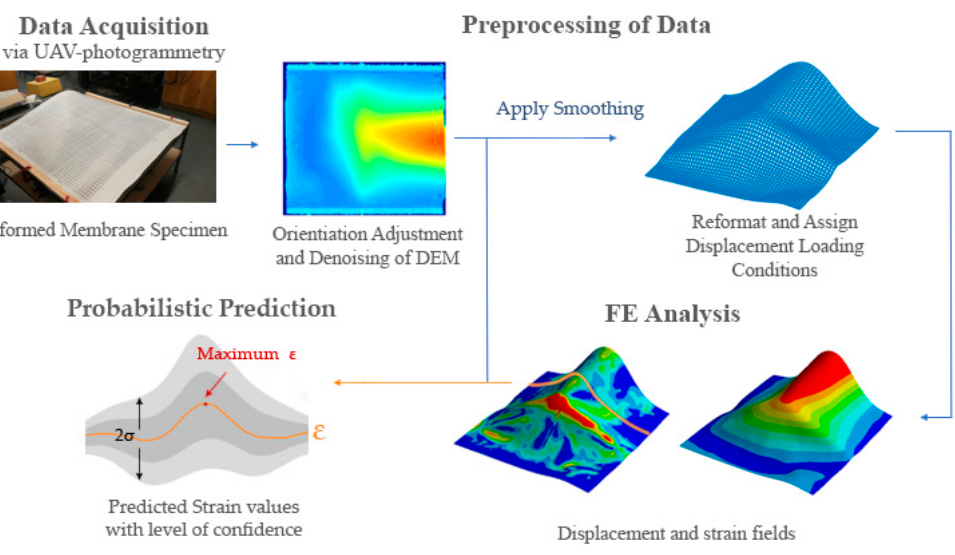
Figure 2. Schematic depiction of the procedure used for strain determination in using a UAV-assisted photogrammetry DEM for deformed membrane covers.